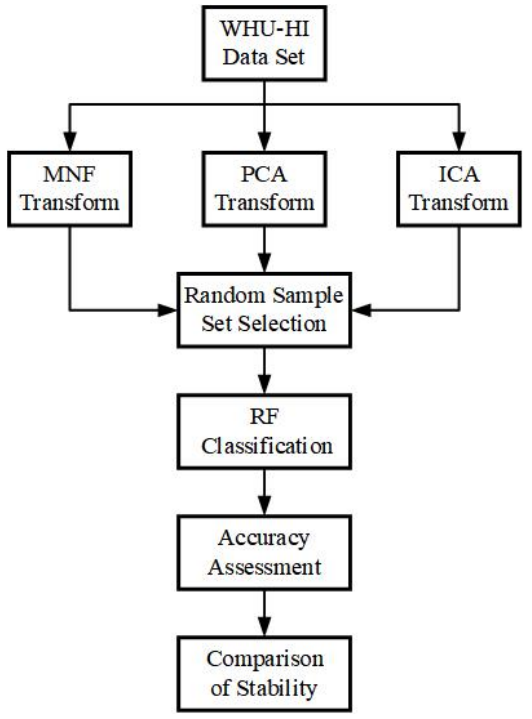
Figure 3. Flow chart of study .